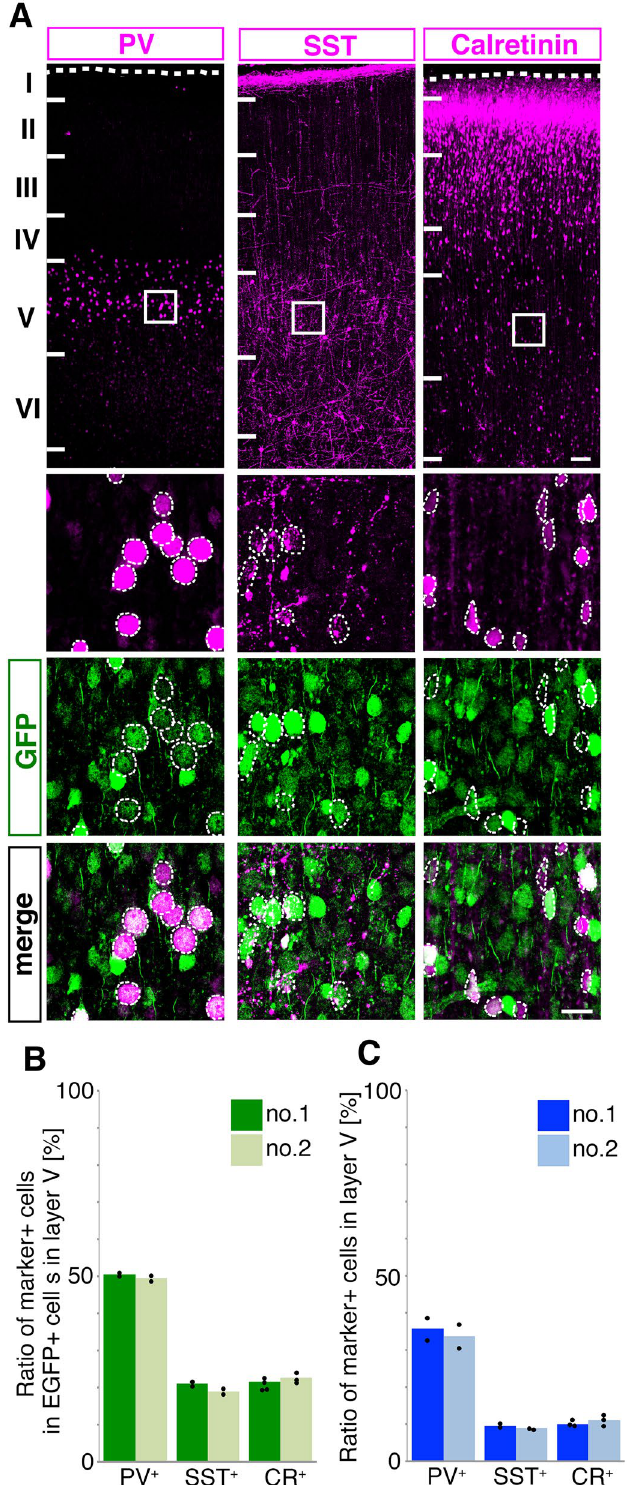
Figure 5. Subtype marker expression in the hGPR56e1m -EGFP positive GABAergic interneurons. ( A ) Distribution of hGPR56e1m -EGFP and PV, SST or Calretinin in the cortical plate of the transgenic marmoset brain (E113). Scale bar = 1 mm. Enlarged images of the area marked by rectangles in top panels are shown in the lower panels. The dashed ellipses indicate the positive cells of each subtype marker of GABAergic neuron. Scale bars = 50 µm. ( B ) Ratio of PV + , CR + , or STT + cells among the hGpr e1m -driven EGFP + cells in the layer V of transgenic marmoset no. 1 and no. 2. ( C ) Ratio of PV + , CR + , or STT + cells among the cells in the layer V of transgenic marmoset no. 1 and no.